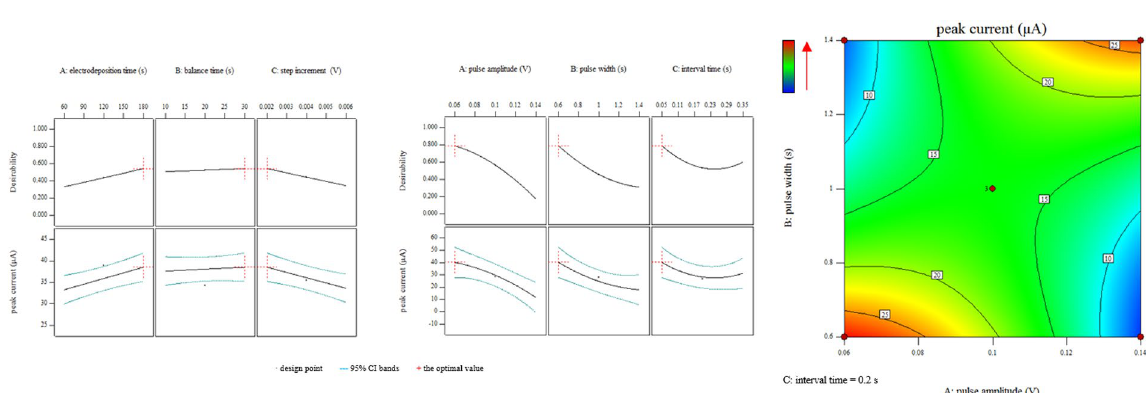
Figure 3. Desirability and 95% prediction intervals of electrodeposition time, balance time, step increment, pulse amplitude, pulse width, interval time and pulse amplitude × pulse width in 0.1 mol/L HCl.